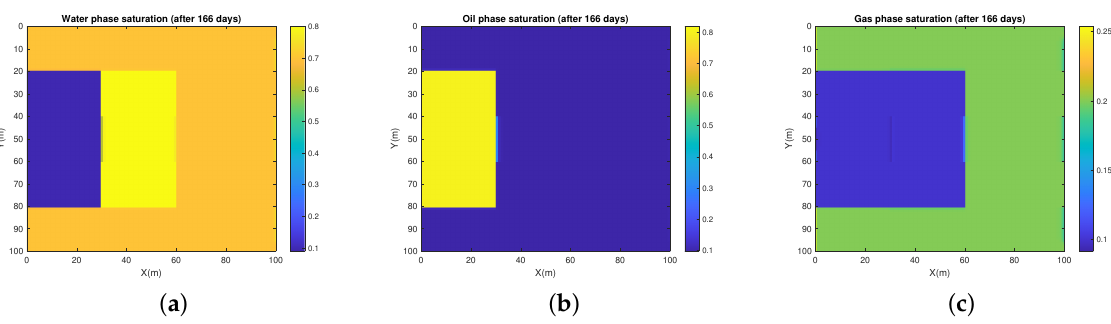
Figure 15. Initial distribution of water ( a ), oil ( b ) and gas ( c ).